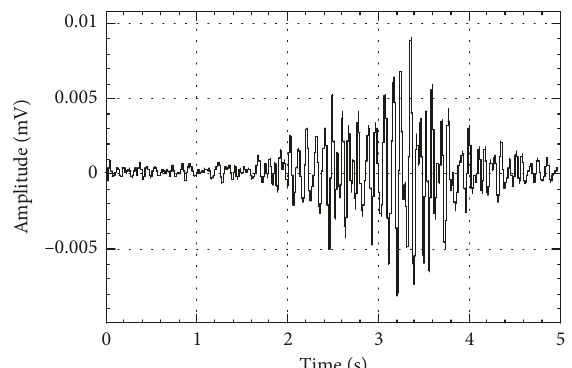
Figure 10: Denoised microseismic